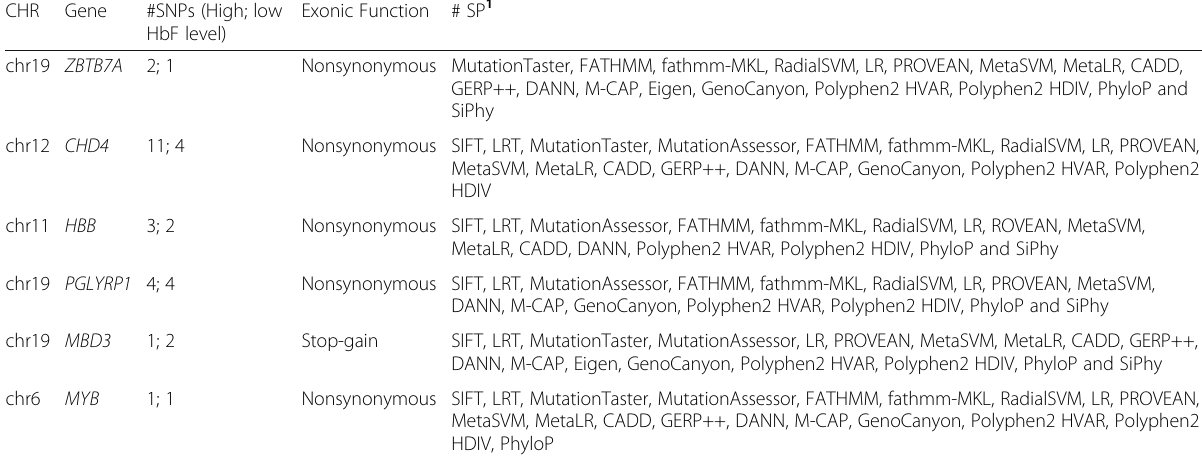
Table 3 Genes with high deleterious and loss-of-function mutations in SCA patients from Tanzania. Details of mutation on SNPs below can be found in Supplementary File: Table